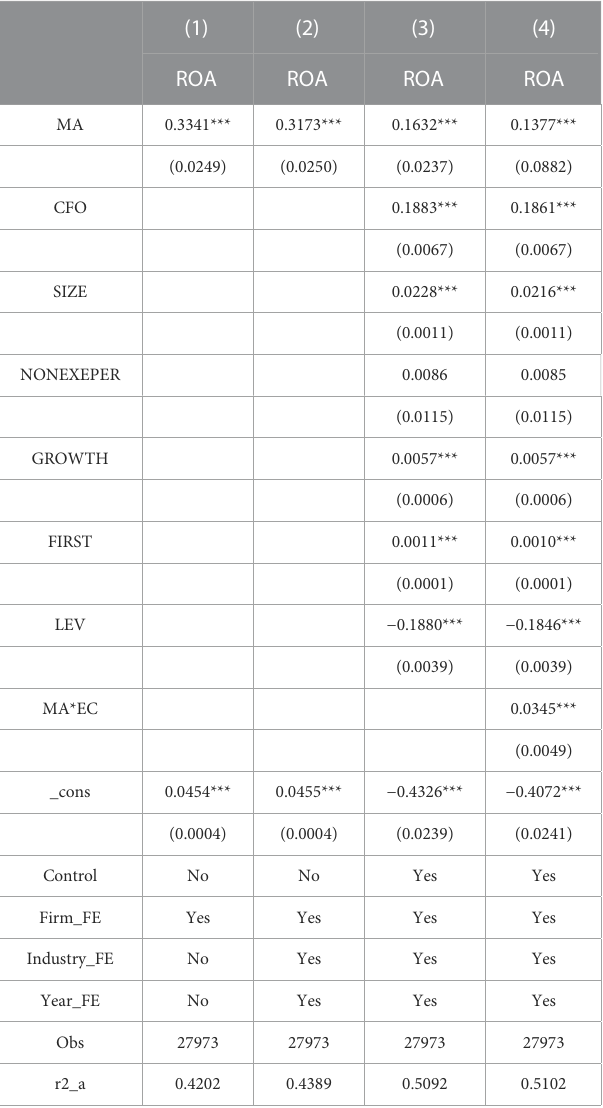
TABLE 2 Benchmark